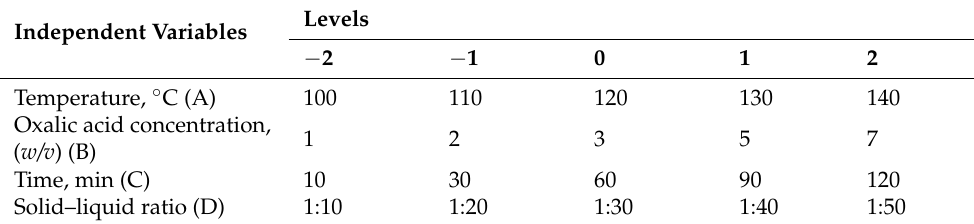
Table 1. Levels of the independent